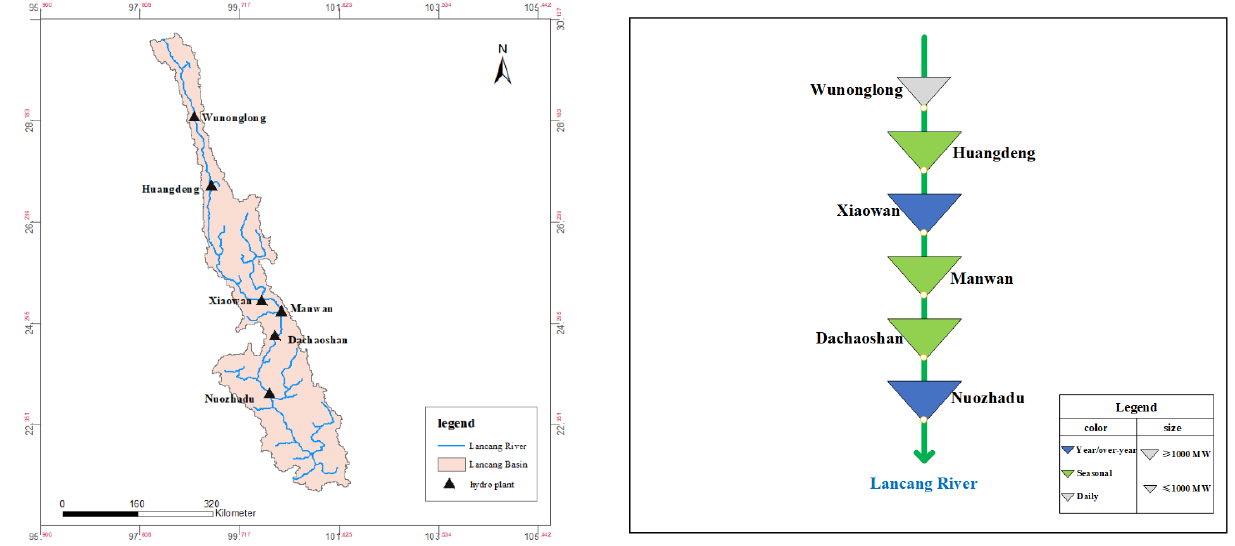
Figure 2. Hydraulic layout of the six reservoirs on the Lancang River.